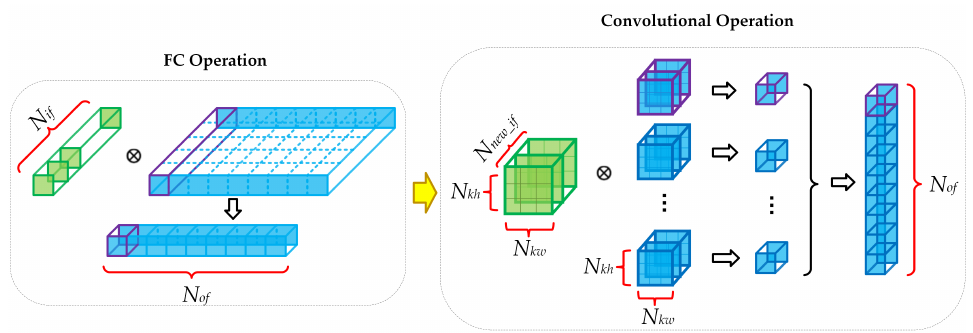
Figure 4. The process of FC operation